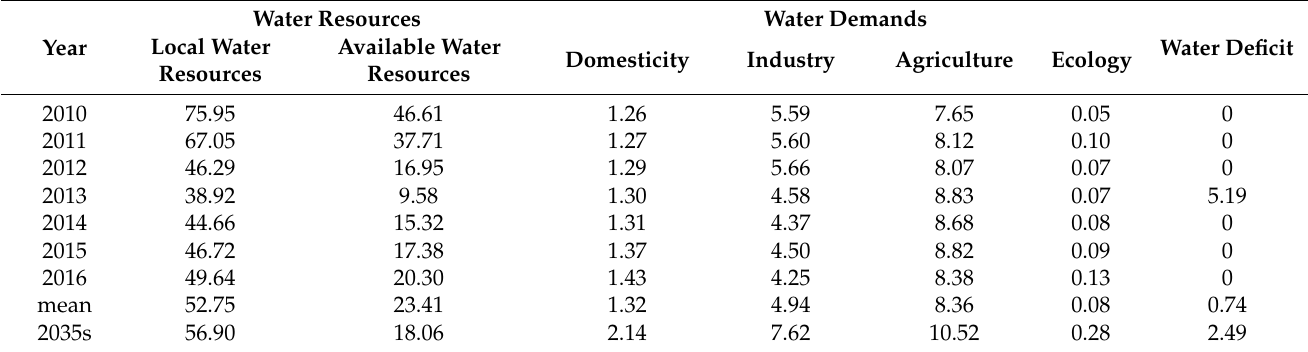
Water DeficitLocal Water